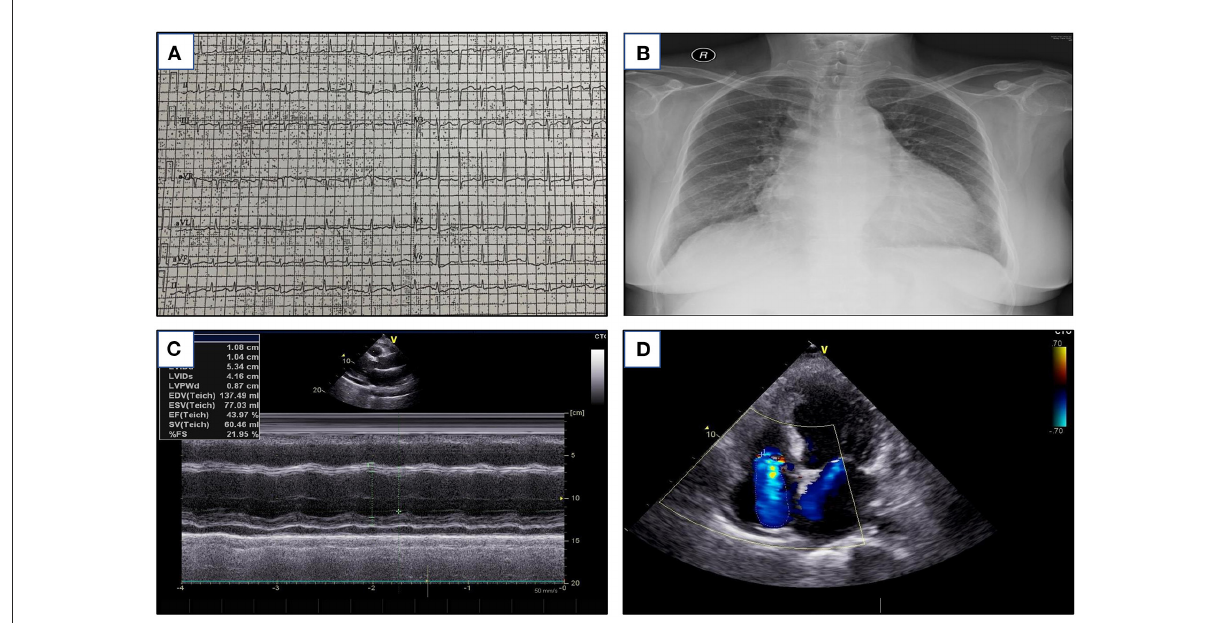
FIGURE1 (A) The ECG at admission (speed 25 mm/s, 10 mm/mV) with HR 128 beats/min and QTc interval of 502ms. (B) The chest radiography shows cardiac enlargement and signs of pulmonary congestion. (C) The echocardiography in the long-axis, M mode shows an increased left ventricular end-diastolic diameter (5.0cm) and reduced EF (43%). (D) Doppler ultrasound shows moderate mitral regurgitation and severe tricuspid